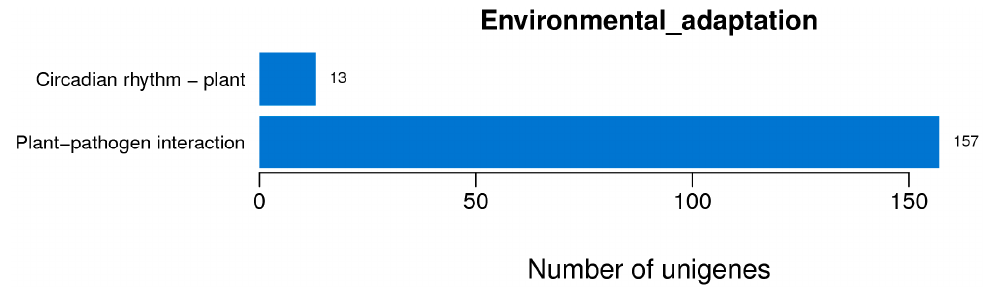
Figure 4. Enrichment of differentially expressed genes (DEGs) related to environmental adaptation. The number of DEGs annotated in this pathway is